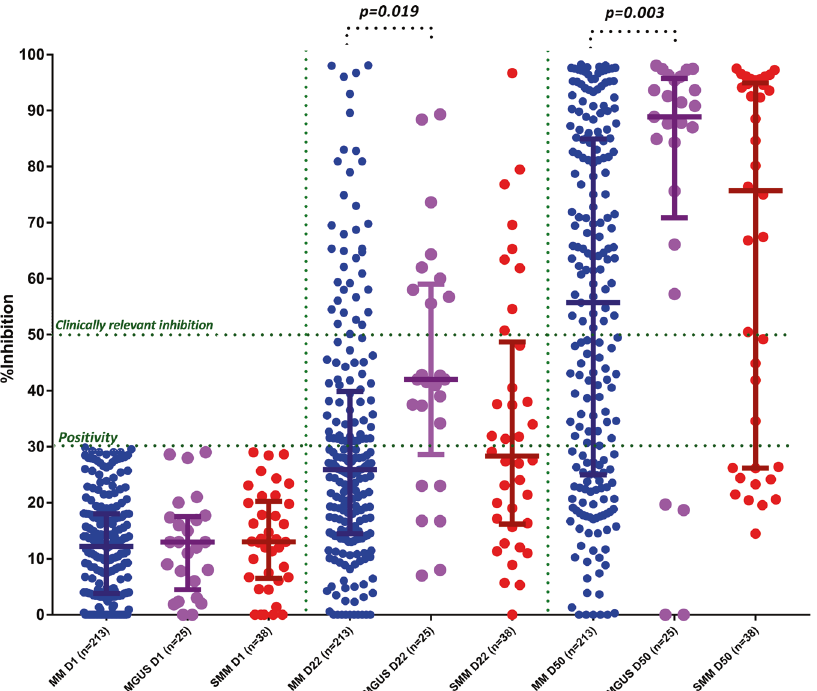
Fig. 3 Kinetics of NAbs in MM compared with SMM and MGUS after vaccination with 2 doses of the BNT162b2 or 1 dose of the AZD1222 vaccine. A statistically signi fi cant difference was identi fi ed both on day 22 and day 50 between the MM and MGUS group. Table 2. Type of treatment for NAbs responders and non-responders on day